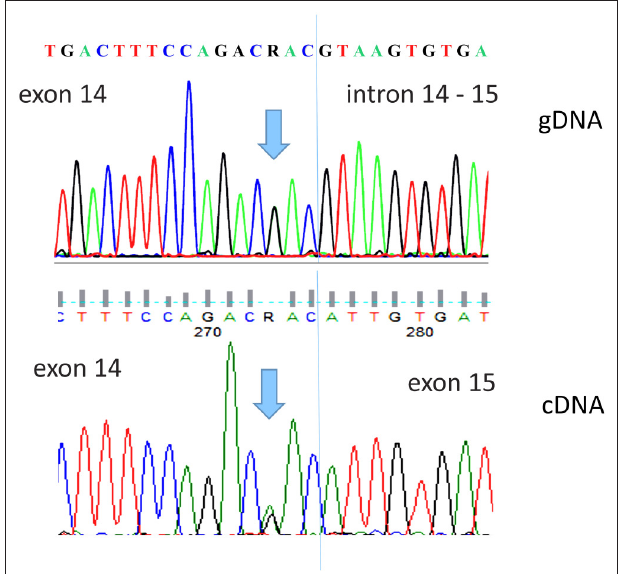
FIGURE 2 | Direct sequence analysis of the DPYD c.1903A > G, p.Asn635Asp variant detected in our patient. The upper panel shows the gDNA sequence of exon 14 and intron–exon border. The lower panel shows the patient cDNA sequence, performed with primers spanning exons 13 and 15, demonstrating the integrity of exon 14.